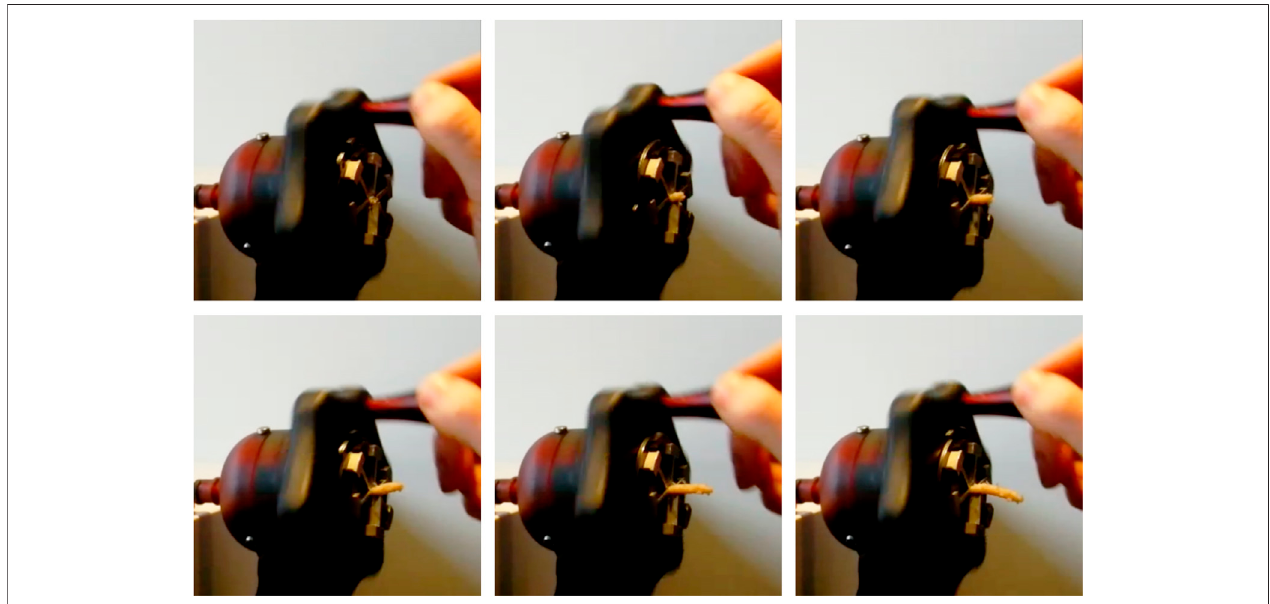
FIGURE 9 | Photo of the tissue leaving at the end of the tissue transport mechanism using manual actuation. The photos were taken one actuation cycle apart.